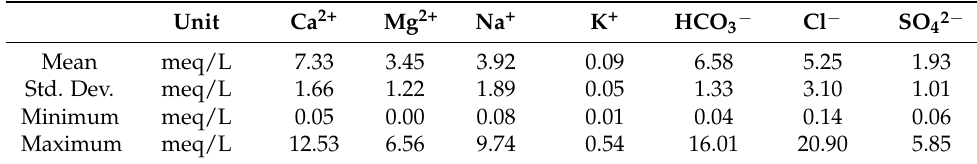
Table 1. Descriptive statistics for the